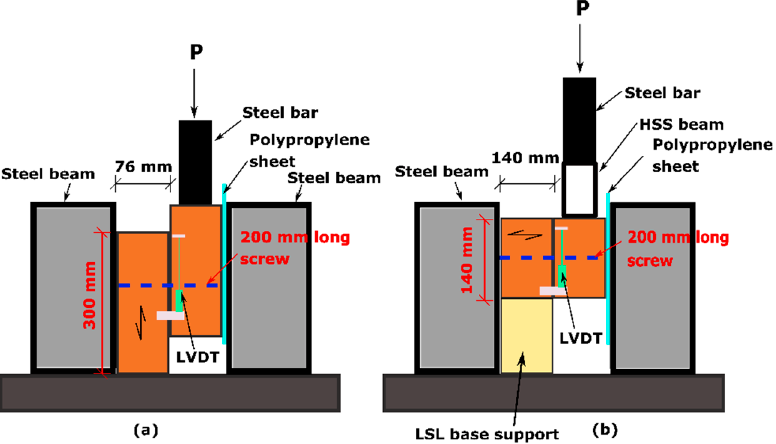
Figure 15. Schematics of Connection-C test setup: ( a ) loading parallel to strand; ( b ) perpendicular to strand.